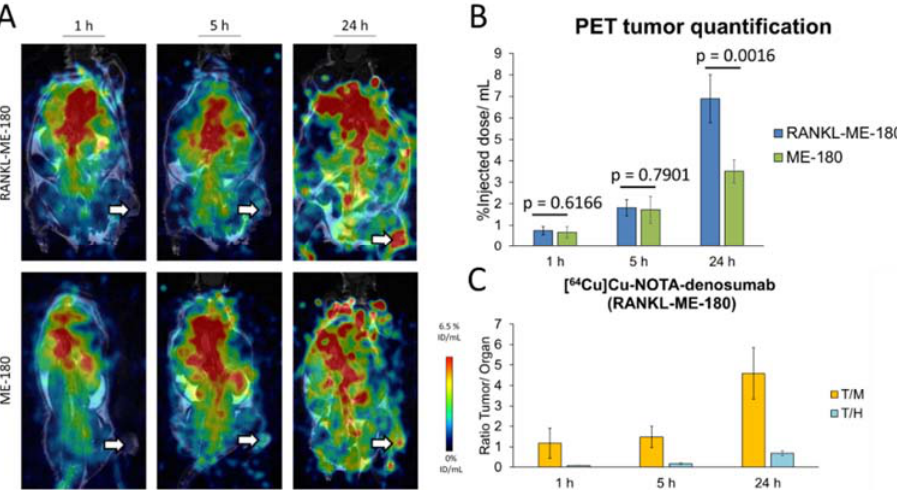
Figure 5. [ 64 Cu]Cu ‐ NOTA ‐ denosumab PET imaging. ( A ) [ 64 Cu]Cu ‐ NOTA ‐ denosumab PET images of RANKL ‐ ME ‐ 180 ( top ) and ME ‐ 180 ( bottom ) xenografts at 1 h, 5 h, and 24 h p.i. ( B ) PET analysis of [ 64 Cu]Cu ‐ NOTA ‐ denosumab tumor uptake. ( C ) [ 64 Cu]Cu ‐ NOTA ‐ denosumab tumor/background ratios in RANKL ‐ ME ‐ 180 xenografts. (ID/mL: injected dose/mL; data graph: mean ± 1 standard deviation; white arrow: tumor, T/M: tumor/muscle, T/H: tumor/heart).